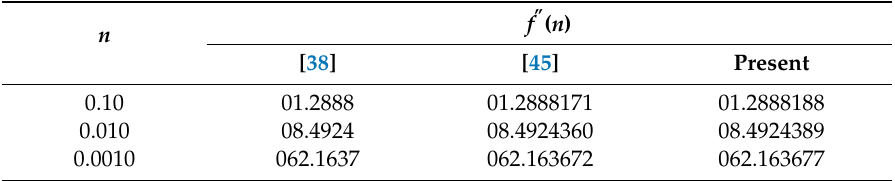
Table 1. Comparison of f (cid:48)(cid:48) ( n ) for varied estimates of n done by Ishaq et al. [38] and Rida et al.